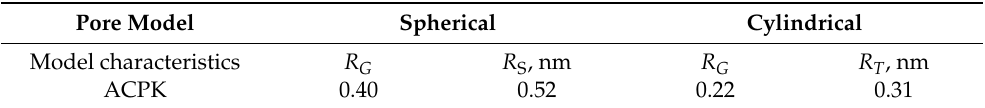
Figure 3. Dependence of the small-angle X-ray scattering intensity on the carbon adsorbent ACPK on the scattering vector at small and medium angles. I – IV are the characteristic X-ray scattering data areas used to obtain the structural parameters of the adsorbents.